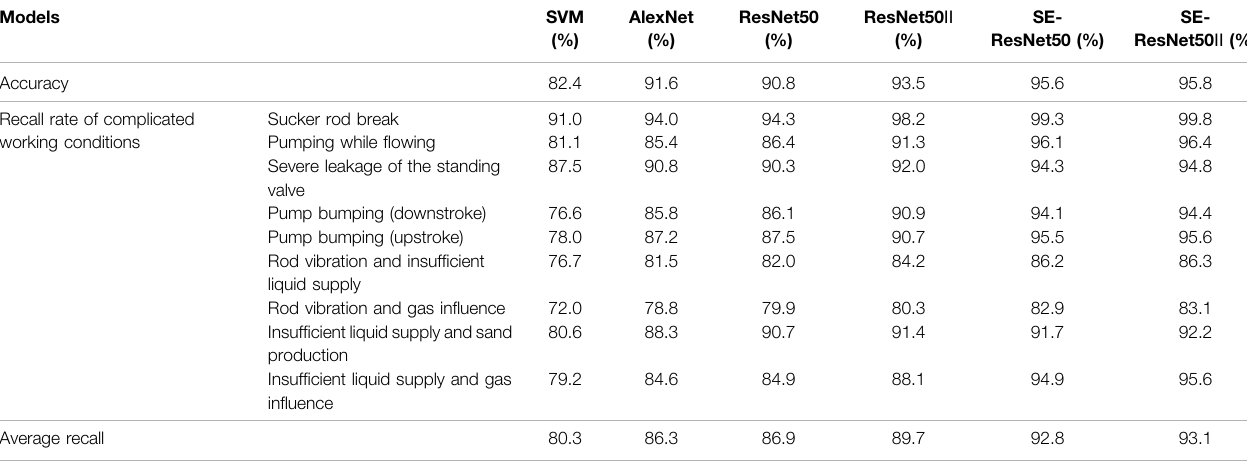
TABLE 9 | Test results of different models.